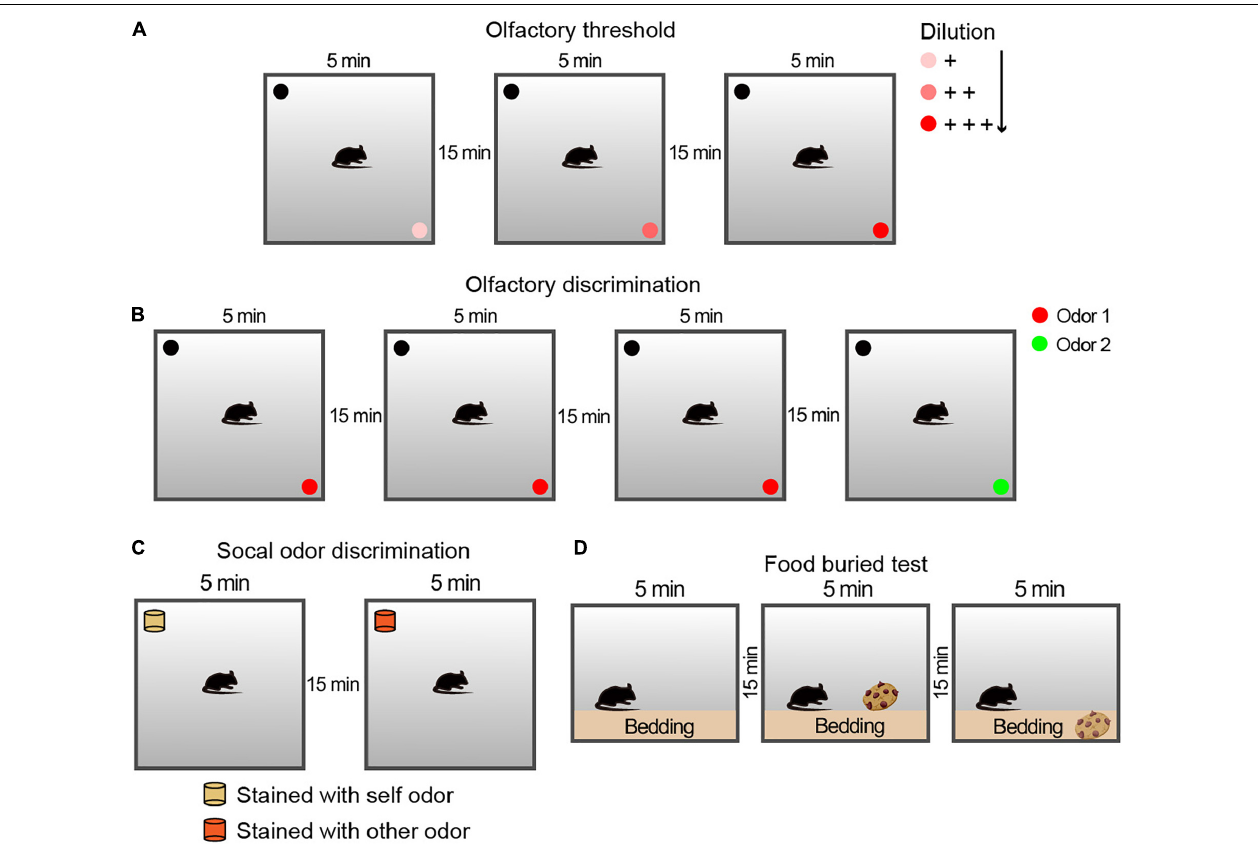
FIGURE 1 | Schematic diagram of the protocol of the behavioral experiment for the olfactory examination. (A) Experimental configuration for the olfactory threshold and sensitivity tests. Each trial lasted for 5 min, followed by a 15-min rest interval. For the avoidance and preference tests, three solutions of different concentrations were used. (B) Experimental configuration for the olfactory discrimination test. Each trial lasted 5 min, followed by a 15-min rest interval. For the olfactory discrimination test, two different odor solutions were used. (C) Schematic drawing of the experimental steps for the social olfactory discrimination test. Each trial lasted 5 min, followed by a 15-min rest interval. The blocks were placed consistently above the bedding between cages in the corresponding home cages. For social odor discrimination, mice were given a comparison between blocks with their own odor and those with the odor of an unfamiliar conspecific male. (D) Schematic drawing of the experimental steps for the buried food test for olfactory function examination. Each trial lasted 3 min, followed by a 15-min rest interval. The cookies were placed above or buried below the bedding in the corresponding two stages.